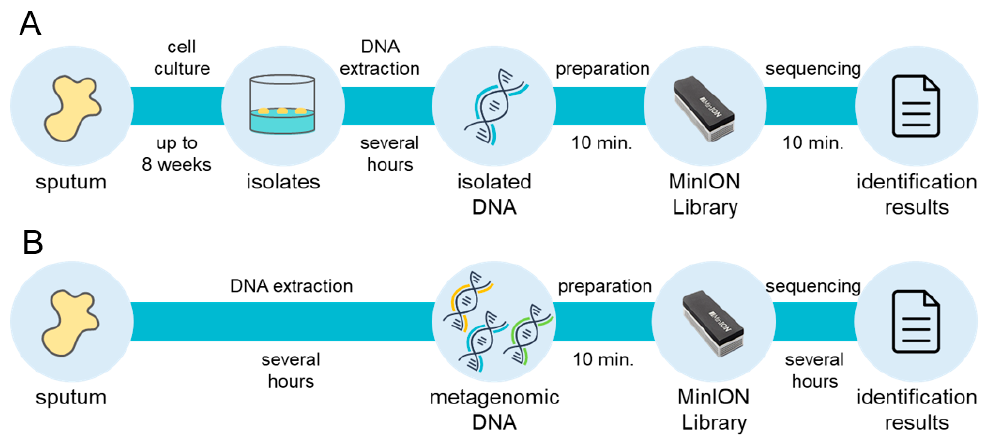
Figure 2. Rapid and comprehensive identification of mycobacteria. Large-scale extension of multi-locus sequence typing (MLST) approach currently achieves comprehensive identification of mycobacteria within 20 min from isolated DNA, although up to 8 weeks is needed for the cell culture step ( A ). A direct metagenomic approach will remove the bottleneck and enable rapid and comprehensive detection of mycobacteria ( B ).